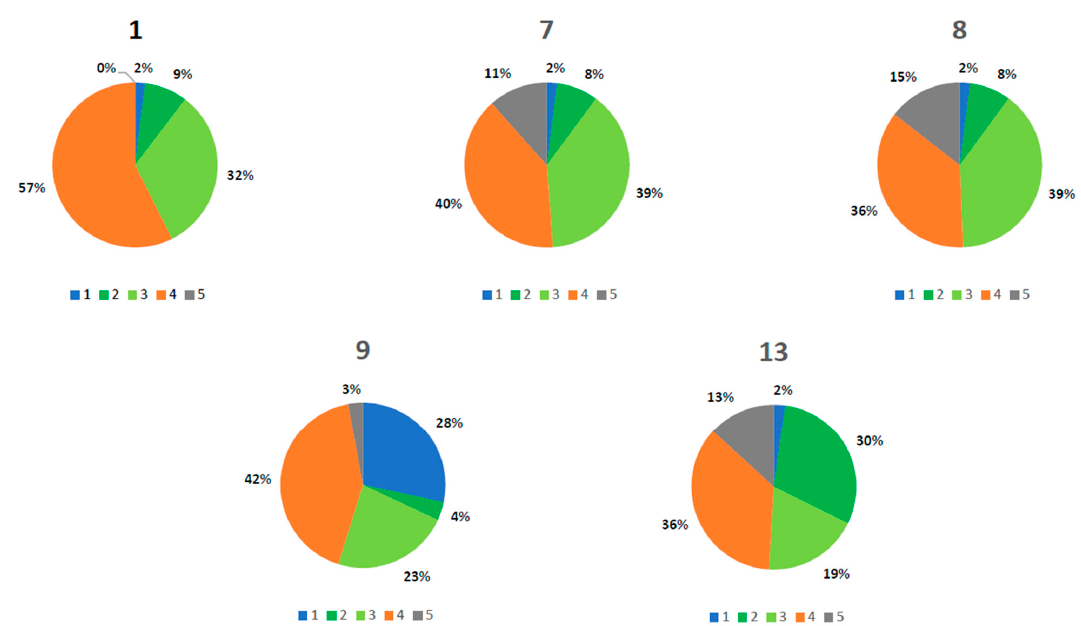
Figure 8. The pixel distribution per class for the Osijek study area.